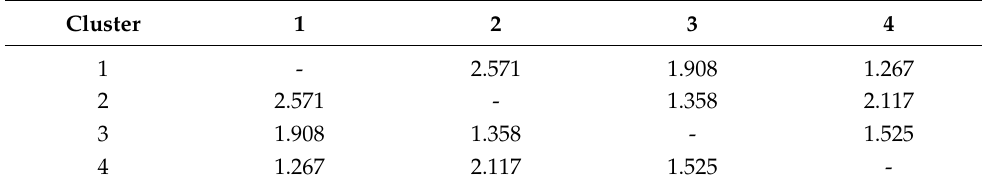
Table 9. Distances between final cluster centers.